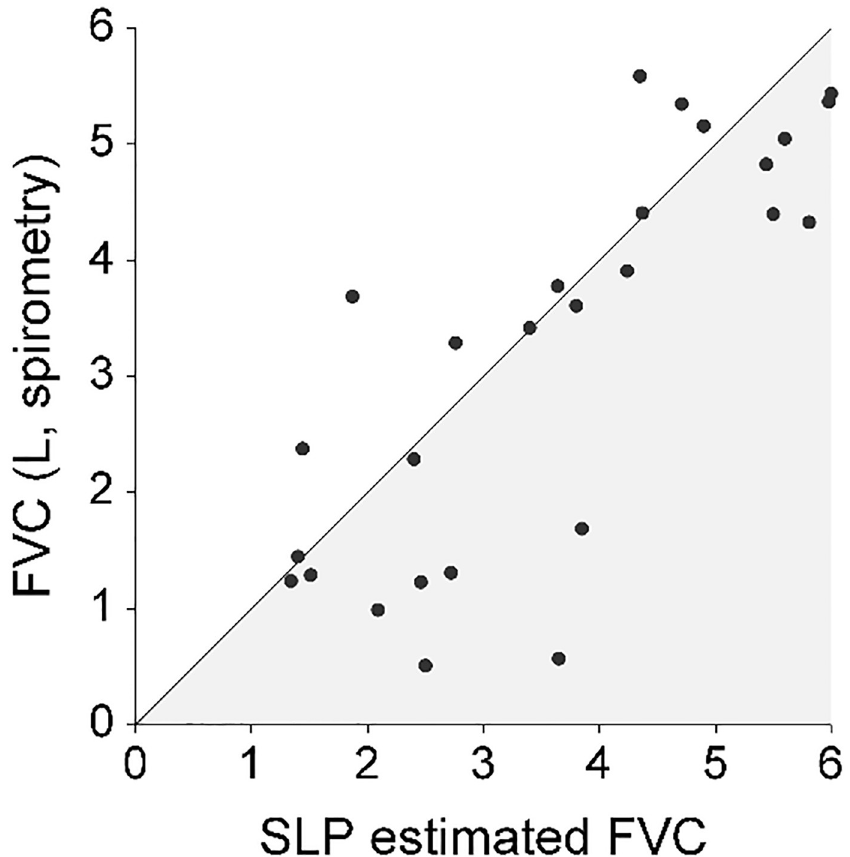
Fig 2. Scatterplot of paired FVC measurements by spirometry and SLP showing the line of identity (perfect agreement). The Pearson’s correlation coefficient was R = 0.78, Lin’s concordance coefficient pc = 0.76.